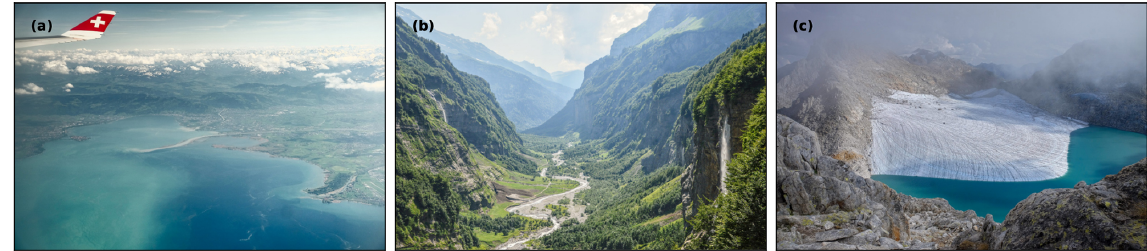
Figure 8. Alpine glacial erosion landscape diversity. (a) Piedmont overdeepening of Lake Constance, ca. 10 × 50km. (b) Glacial trough at Bout du Monde, ca. 1 × 10km. (c) The unusually deep mountain cirque revealed by the current demise of Chüeboden Glacier, ca. 1 ×